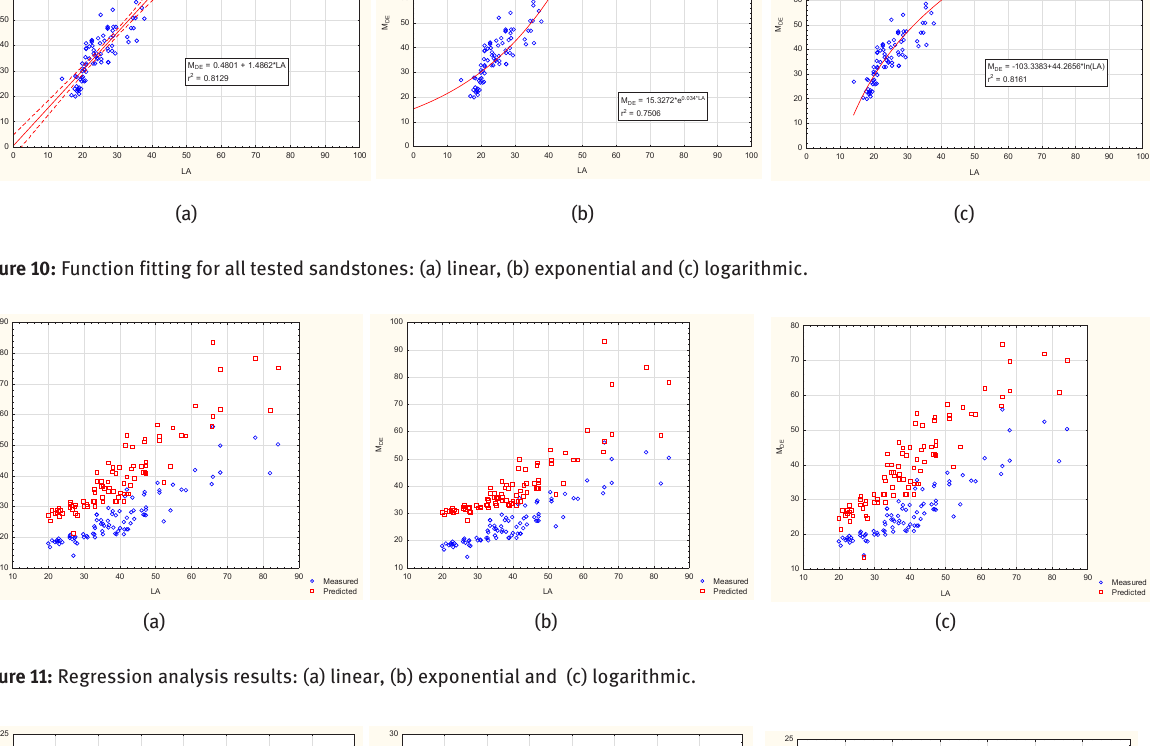
Fig. 11. Regression analysis results: (a) linear, (b) exponential and (c) logarithmic